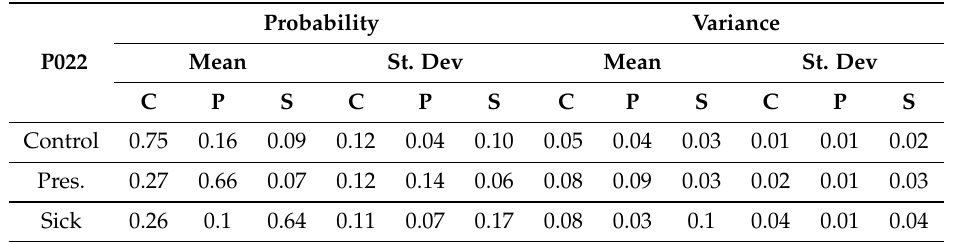
Table 1. Mean and standard deviation values computed from the probabilities and variances for the presymptomatic register P022 that are illustrated in Figure